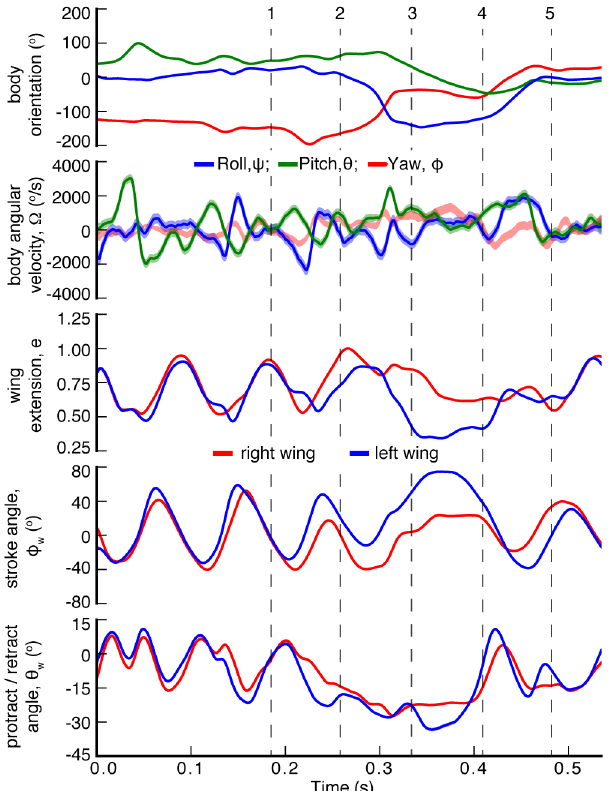
Fig 3. Changes to a landing bat ’ s body orientation, roll, ψ , pitch, θ , and yaw, ϕ , are prompted by pronounced changes in its wing kinematics. The top two frames indicate body orientation and angular velocity (about body-fixed axes). The lower three frames show simplified wing kinematics: instantaneous wing extension, e , wing stroke angle, ϕ w , and protraction-retraction angle, θ w . The departure from symmetric left-right wing motion coincides with changes in the body orientation. The five moments in time indicated by dashed vertical lines correspond to the images shown in Fig 2.